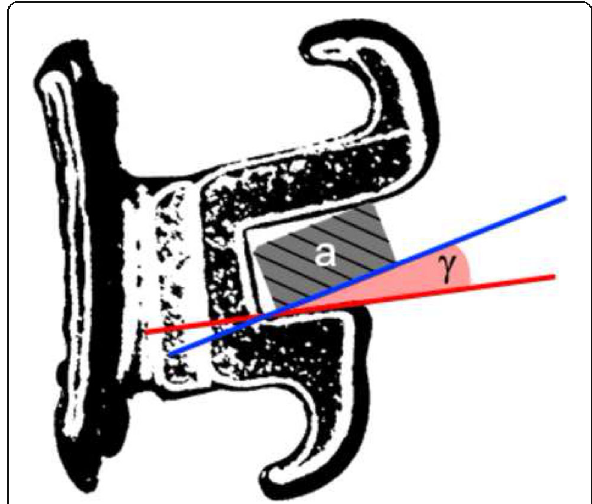
Fig. 4 Depiction of the torsional play angle ( γ ) between the bracket ’ s slot and the archwire